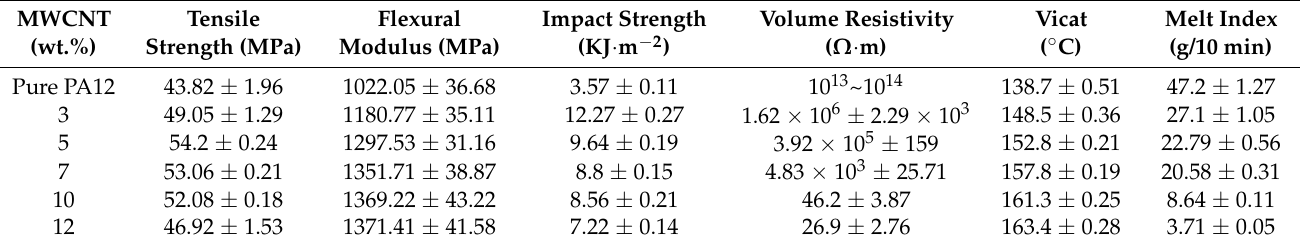
Table 3. Properties of composites with different proportions of MWCNTs.